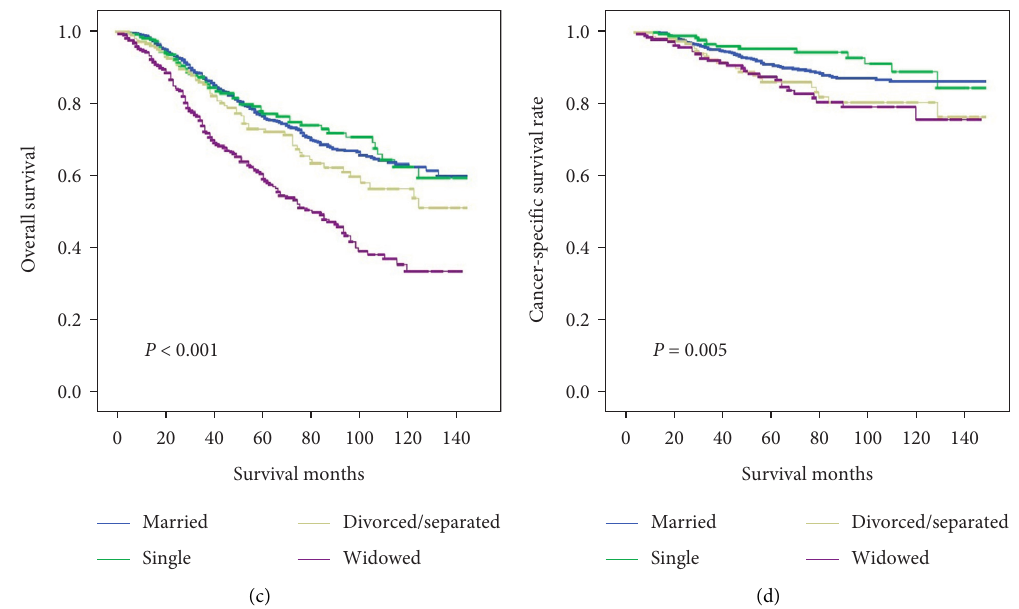
Figure 3: Kaplan–Meier comparison of OS and CSS among patients stratified by gender. (a, b) Male patients and (c, d) female patients.